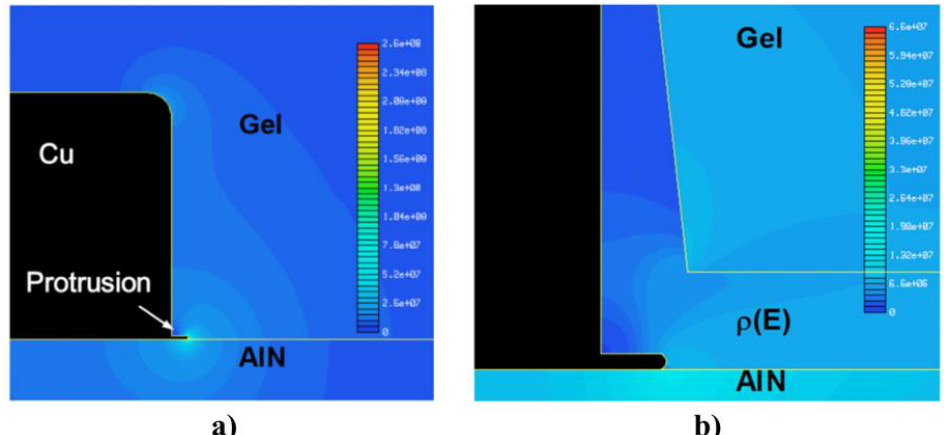
Figure 54. Electrical field calculated by finite element simulation. Material ( a ) without and ( b ) with a nonlinear field-grading layer. © 2021 IEEE. Reprinted, with permission, from [33].